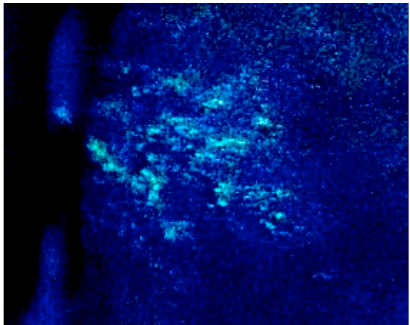
Figure 1. Wood’s lamp illumination of guinea pig skin after reactivation of the varicella-zoster virus (VZV). A hairless guinea pig was inoculated with lymphocytes infected with VZV modified